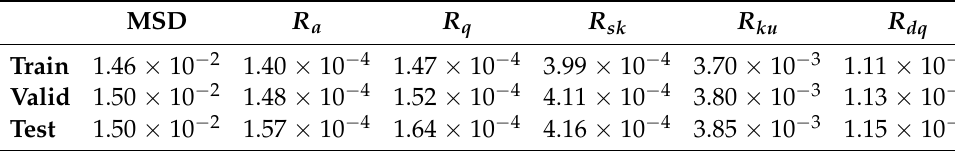
Figure 14. Training vs. Validation. Table 6. Mean difference on test set with MSE.